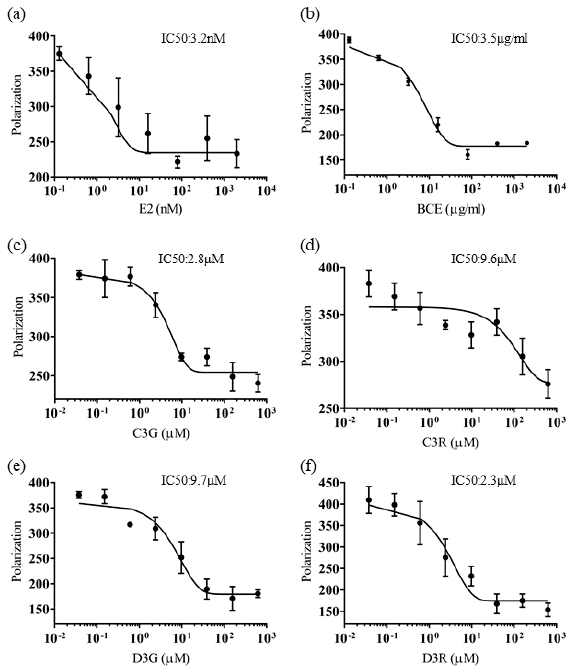
Figure 3. Competitive binding curves of blackcurrant anthocyanin-induced displacement of fluorescein-labeled 17 β -estradiol (E2) from human ER β . ER β and fluorescein-labeled estradiol were incubated for 2 h with a serial dilution of ( a ) E2; ( b ) blackcurrant extract; ( c ) cyanidin-3-glucoside (C3G); ( d ) cyanidin-3-rutinoside (C3R); ( e ) delphinidin-3-glucoside (D3G); and ( f ) delphinidin-3-rutinoside (D3R) at least in triplicate. IC 50 corresponds to the concentration of test compound inhibiting 50% of binding of 4.5 nM Fluormone ES2 Green to ER β . Error bars represent the standard error of the mean.